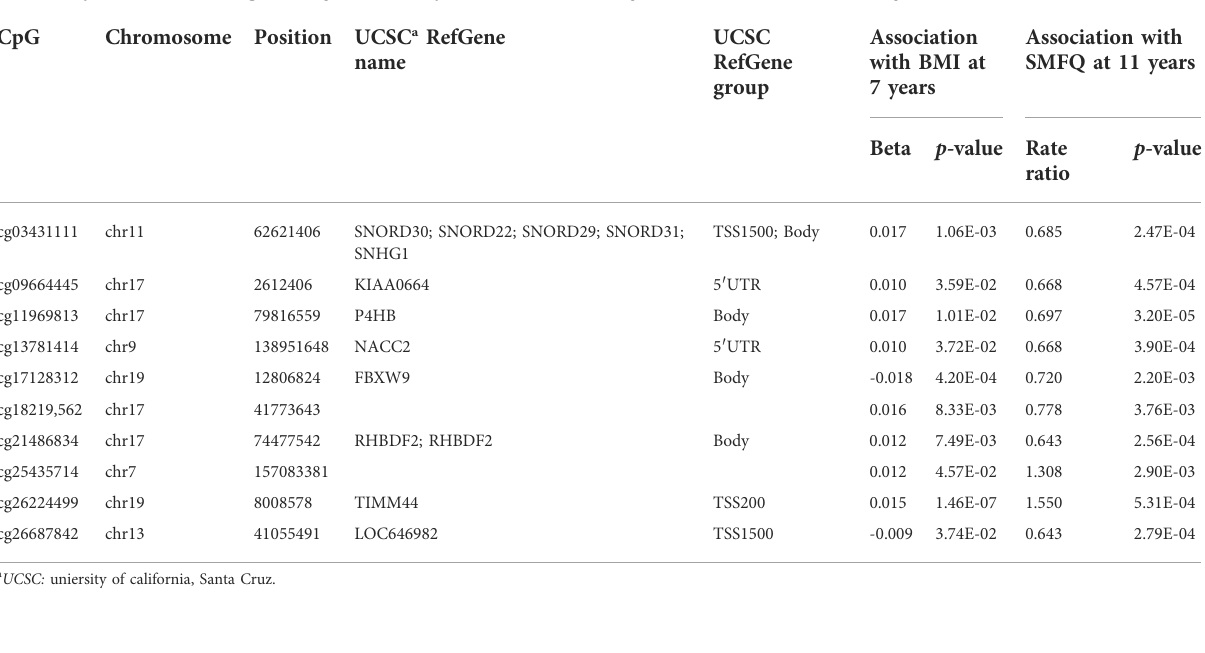
TABLE 4 CpGs simultaneous signi fi cantly associated ( p < 0.05) with BMI at 7 years and (FDR 5%) SMFQ at 11